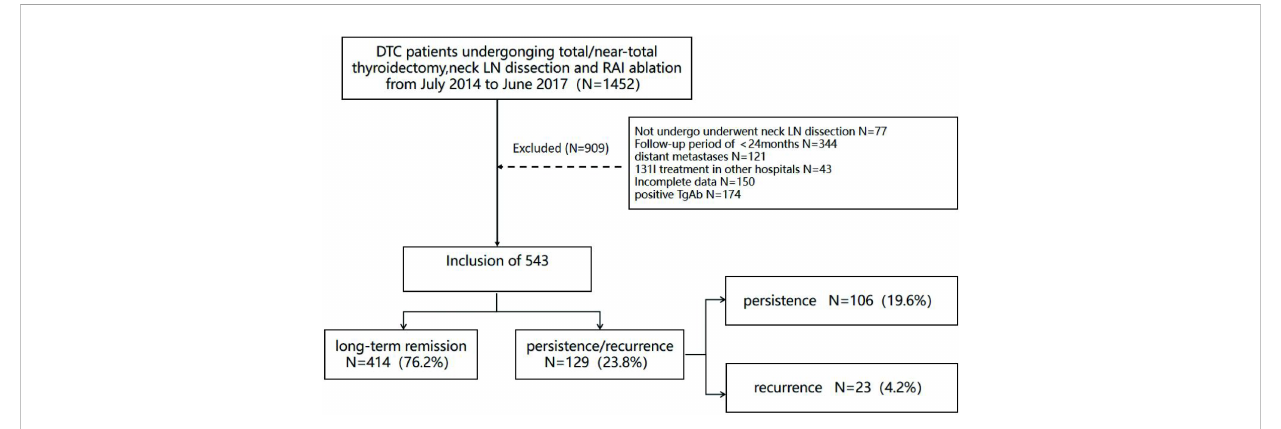
FIGURE 1 Initial patients ’ selection, occurrence of persistence/recurrence during